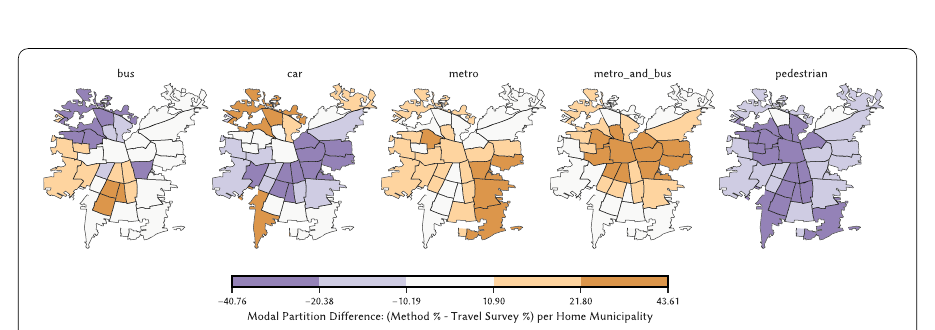
Figure 13 Spatial distribution of the differences of XDR-inferred mode of transportation usage with the modal partition from the Travel Survey. A divergent color palette was used to fill each municipality: grey municipalities exhibit similar values to those from the Travel Survey; orange municipalities have more XDR-inferred trips than in the survey; and purple municipalities have less XDR-inferred trips than in the